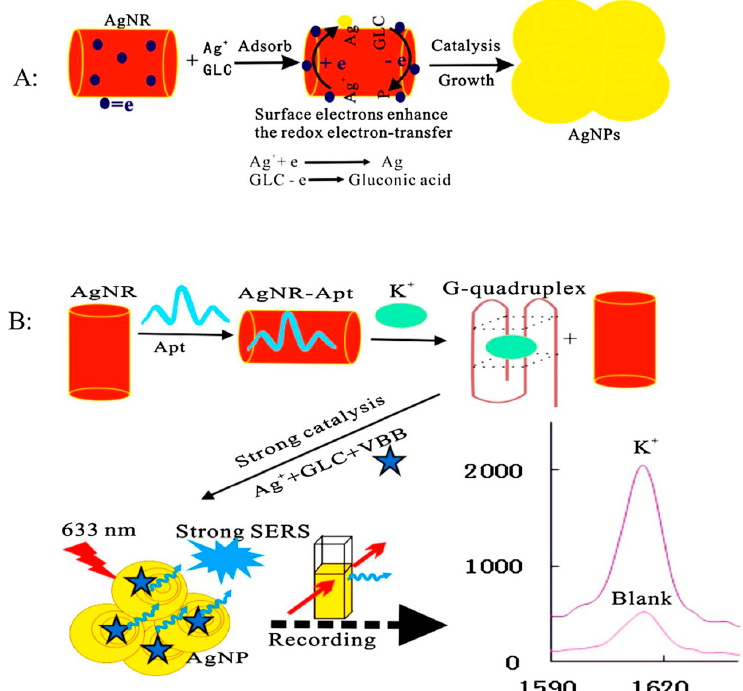
Figure 4. The principle of Ag nanoplasmon SERS detection of trace potassium by aptamer regulating AgNR catalysis. ( A ): Schematic diagram of the production process of AgNPs; ( B ): Schematic diagram of the detection process of K + . (Reprinted with permission from Elsevier, 2019 [62]).